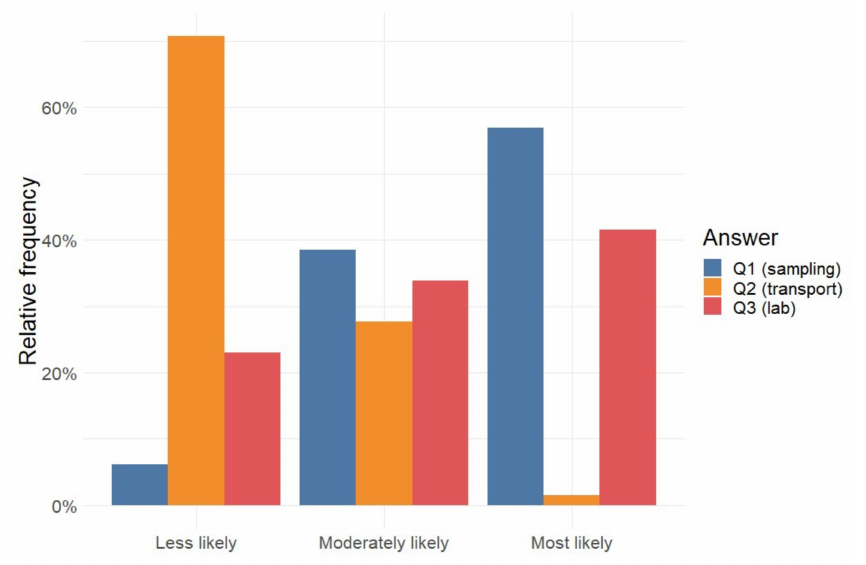
Figure 4. Poultry veterinarian (N = 65) opinions on the less, moderate, and most likely source of contamination of Salmonella samples in poultry breeding flocks leading to false positive routine Salmonella monitoring